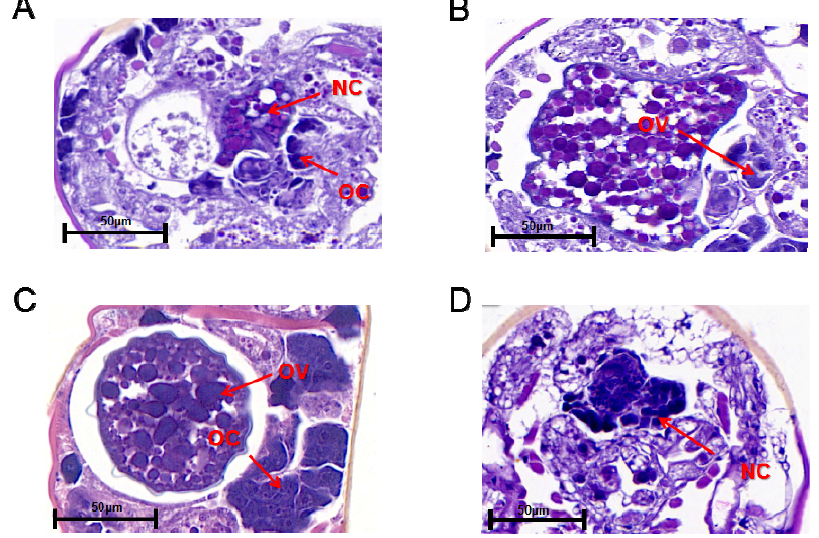
Figure 3. Longitudinal sections of the ovaries of non-diapause N. barkeri adults reared at 25 °C ( A – C ) and those of diapause adults reared at 18 °C ( D ). ( A ) Day 1 of non-diapause female adult mite stage. ( B ) Day 2. ( C ) Day 3. ( D ) Day 5 (diapause stage). OC, oocyte; NC, nurse cell; OV, ovum. Scale bar = 50 µm.